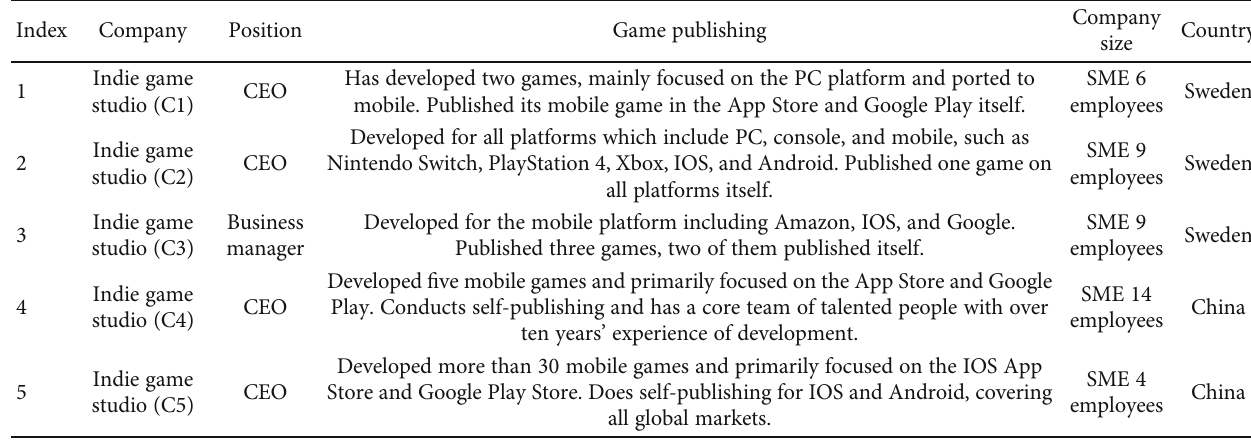
Table 1: Details of indie game developer